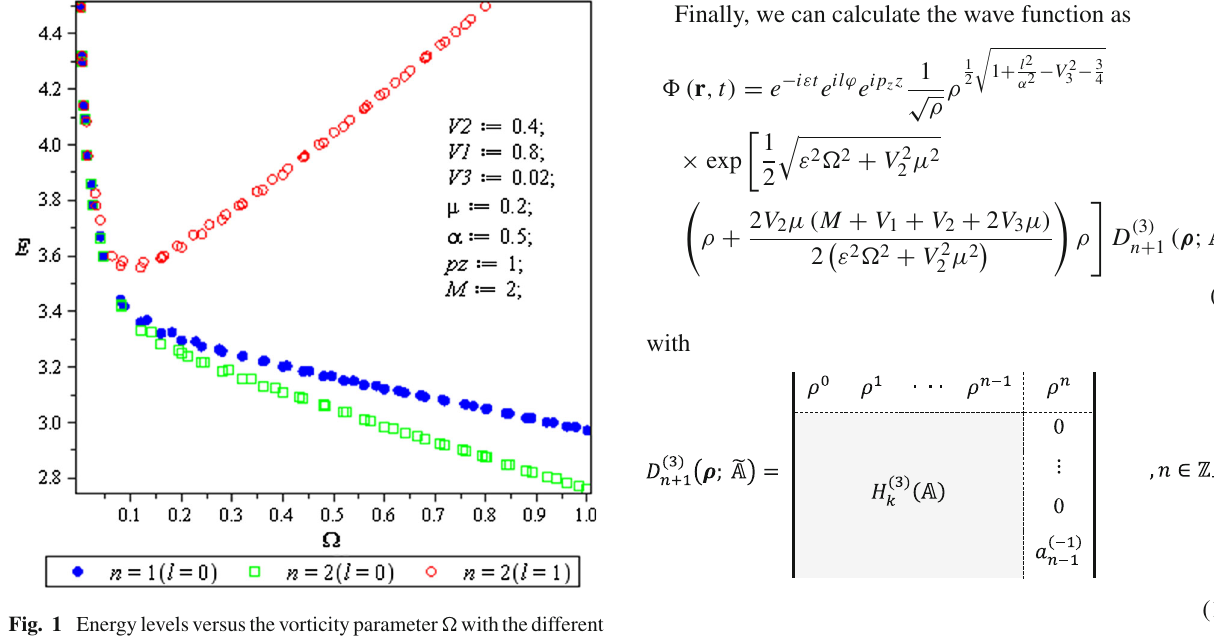
Fig. 1 Energylevelsversusthevorticityparameter (cid:5) withthedifferent n and l